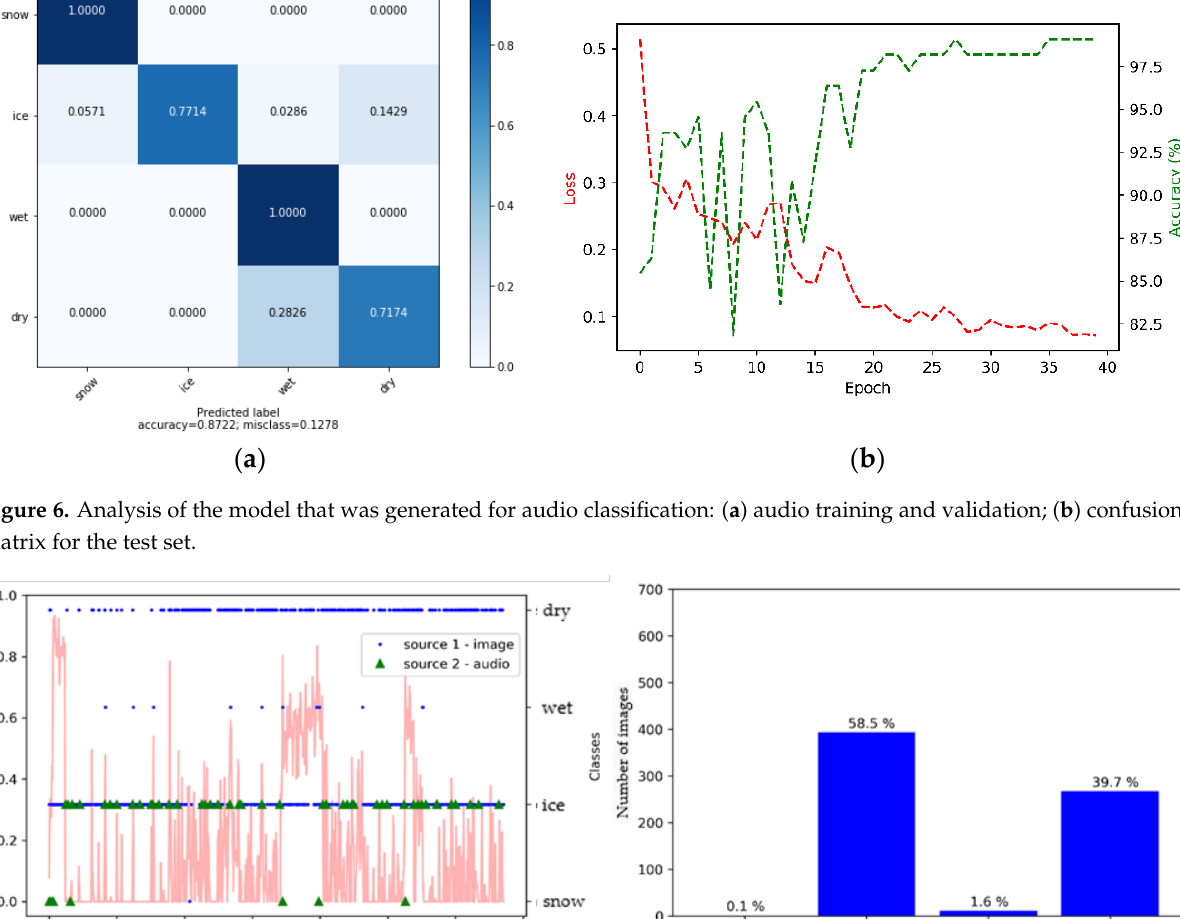
Figure 6. Analysis of the model that was generated for audio classification: ( a ) audio training and validation; ( b ) confusion matrix for the test set.